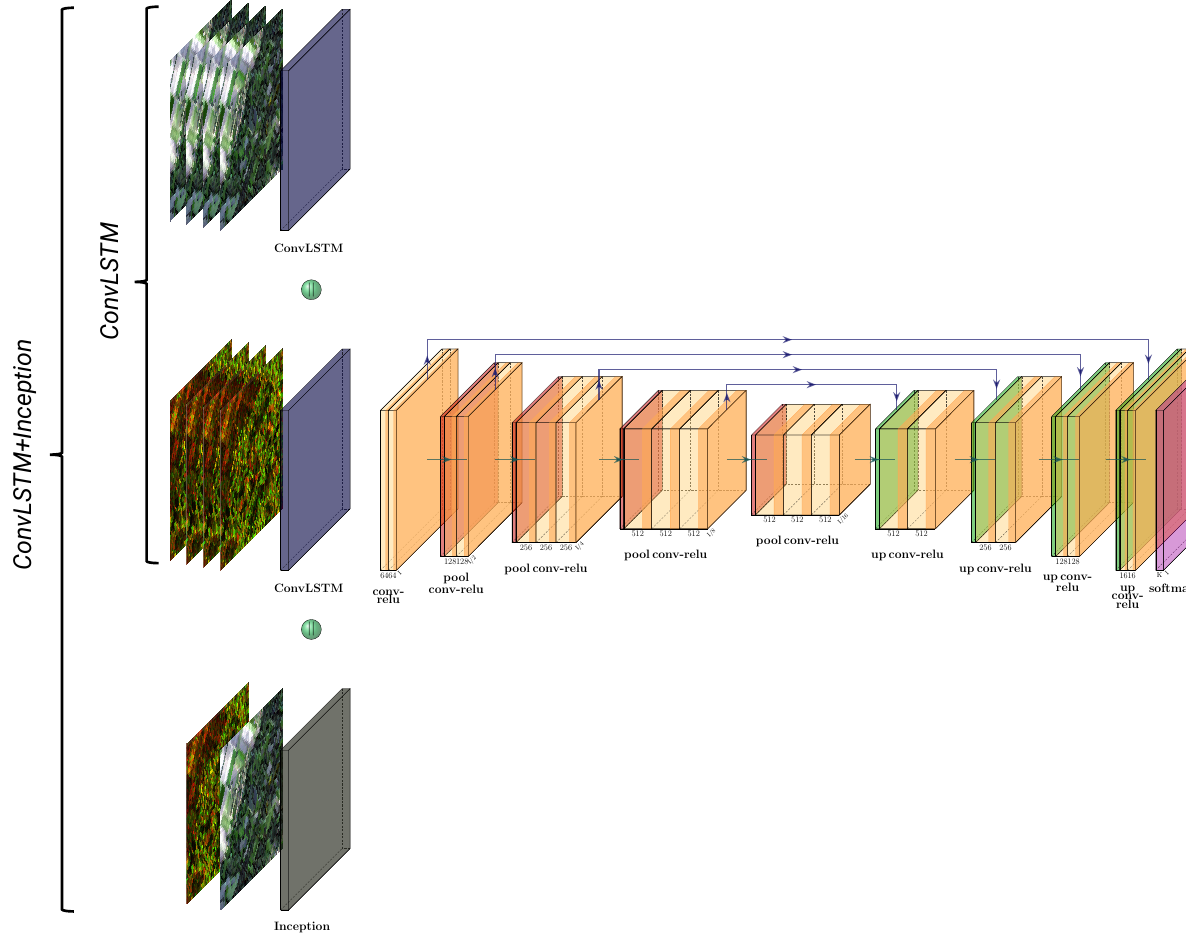
Figure 5. Sentinel-1 and Sentinel-2 ConvLSTM+Inception method ( tion module has been added and the U-Net netwrok take as input the concatenation of the 2 ConvLSTM and the Inception module. This network is used for ConvLSTM and ConvLSTM+Inception